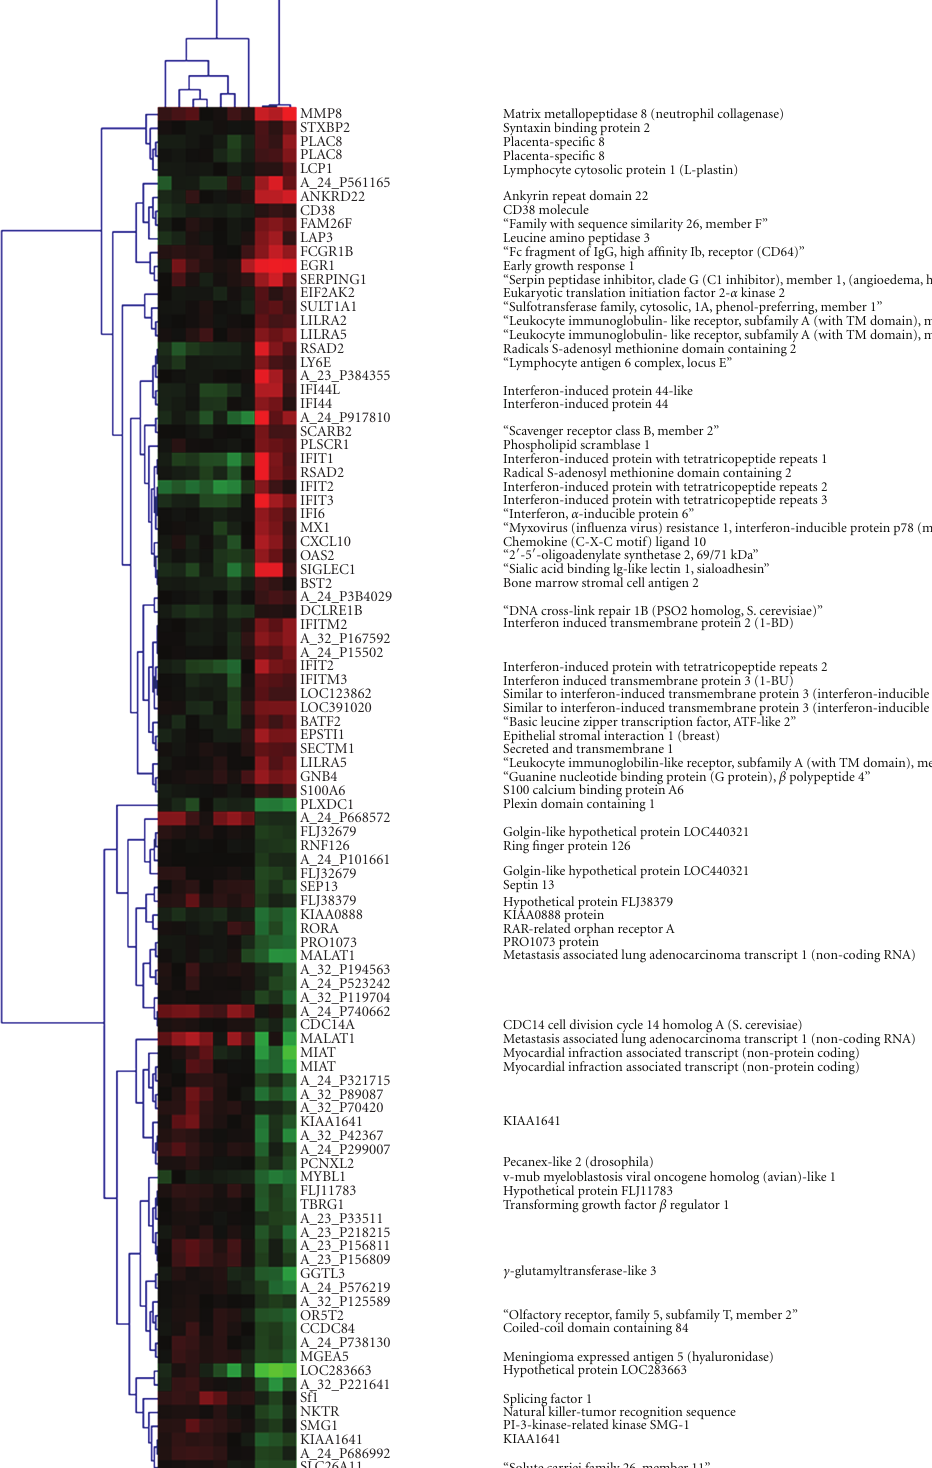
Figure 1: Clustered heat map of top 100 up- and down-regulated genes in patients with advanced transplant coronary artery disease and controls. Gene symbol and gene name are provided when available. Platform unique identifier is provided